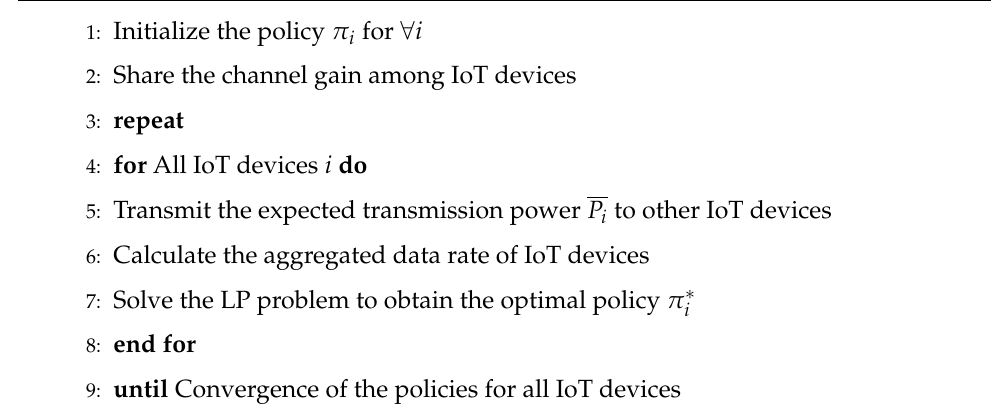
Algorithm 1: Best response dynamics-based